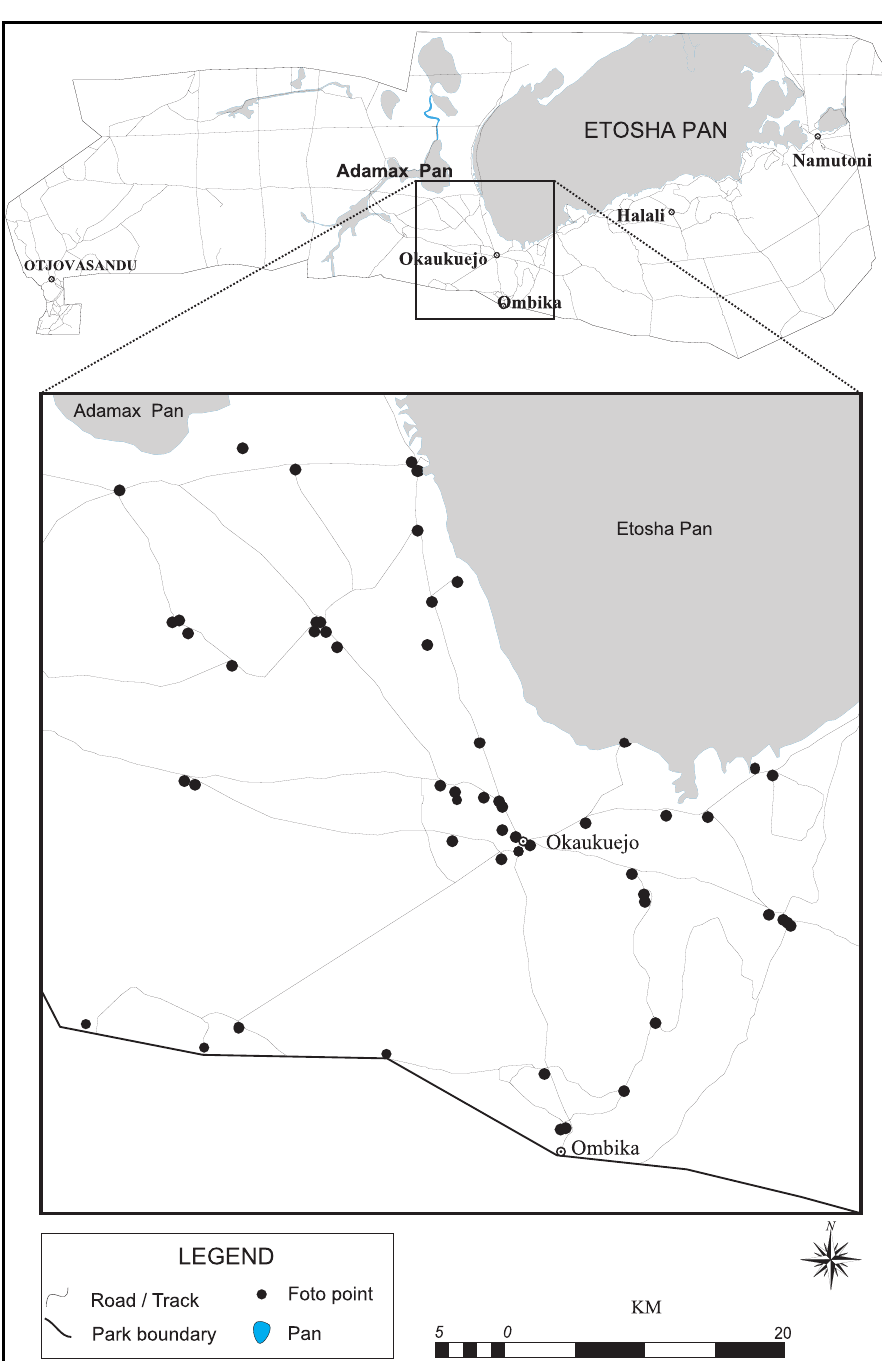
Fig. 2. Location of the study area and photo points in Etosha National